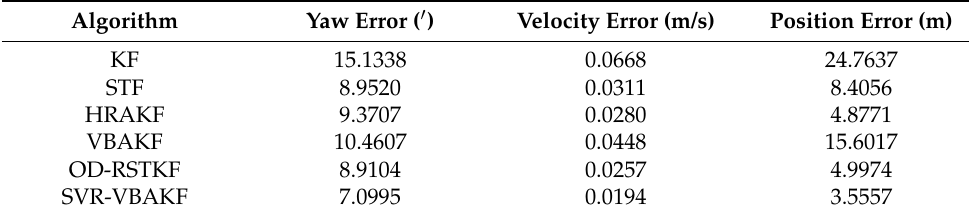
Figure 9. Position error results of various filters ( a ) Position angle error of various filters under 50 Monte Carlo simulations; ( b ) Mean and STD of position errors of various filters under 50 Monte Carlo simulations. Table 1. Mean for Yaw, Velocity and Position RMSE.